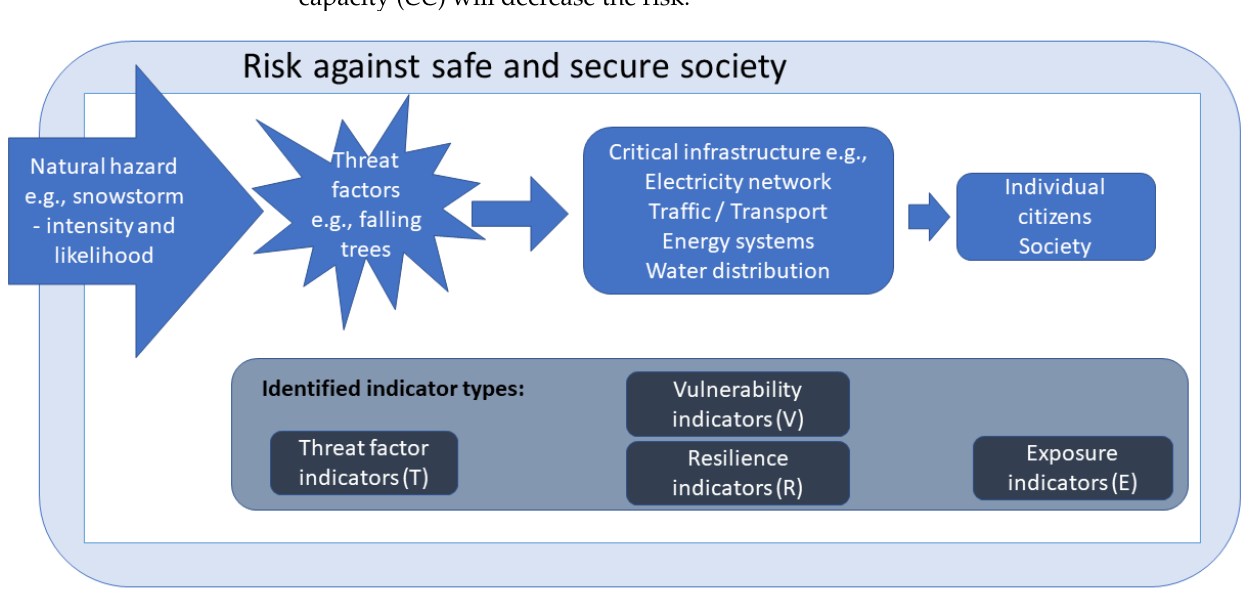
Figure 2. Framework to look for the indicators to assess the risk against a safe and a secure society.